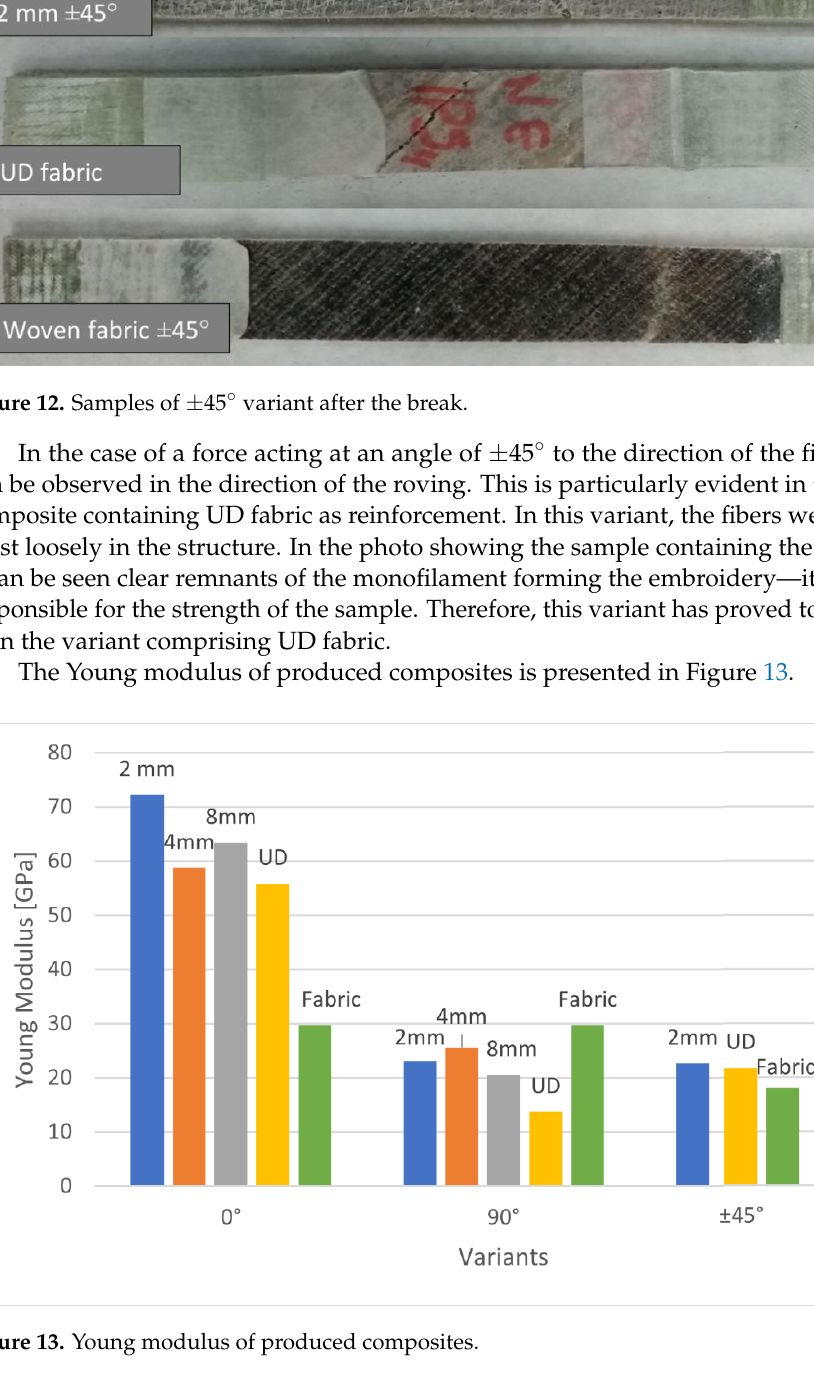
Figure 11. Strength and strain of the ±45° variants.